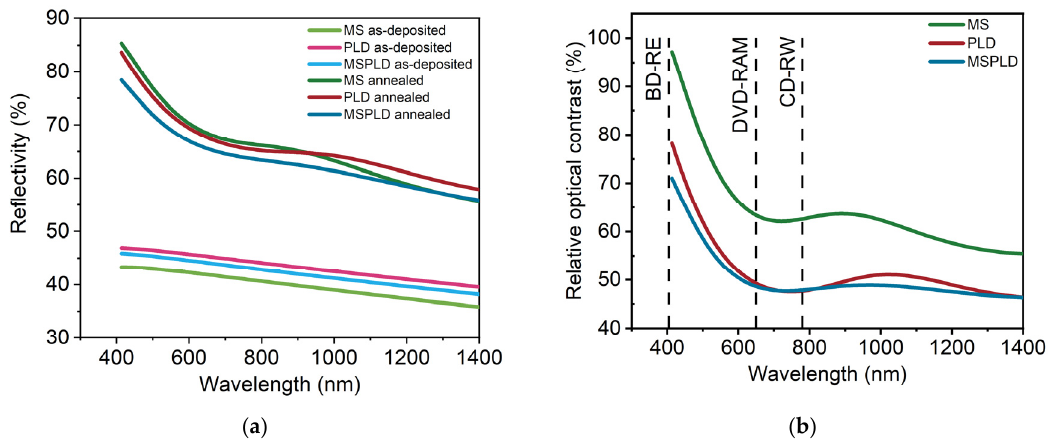
Figure 4. Optical reflectivity ( a ) and Relative optical contrast ( b ) for MS, PLD and MSPLD GST-225 films. The wavelengths of interest for CD-RW, DVD-RAM and BD-RE, namely 405, 650 and 780 nm, are evidenced by dashed lines.